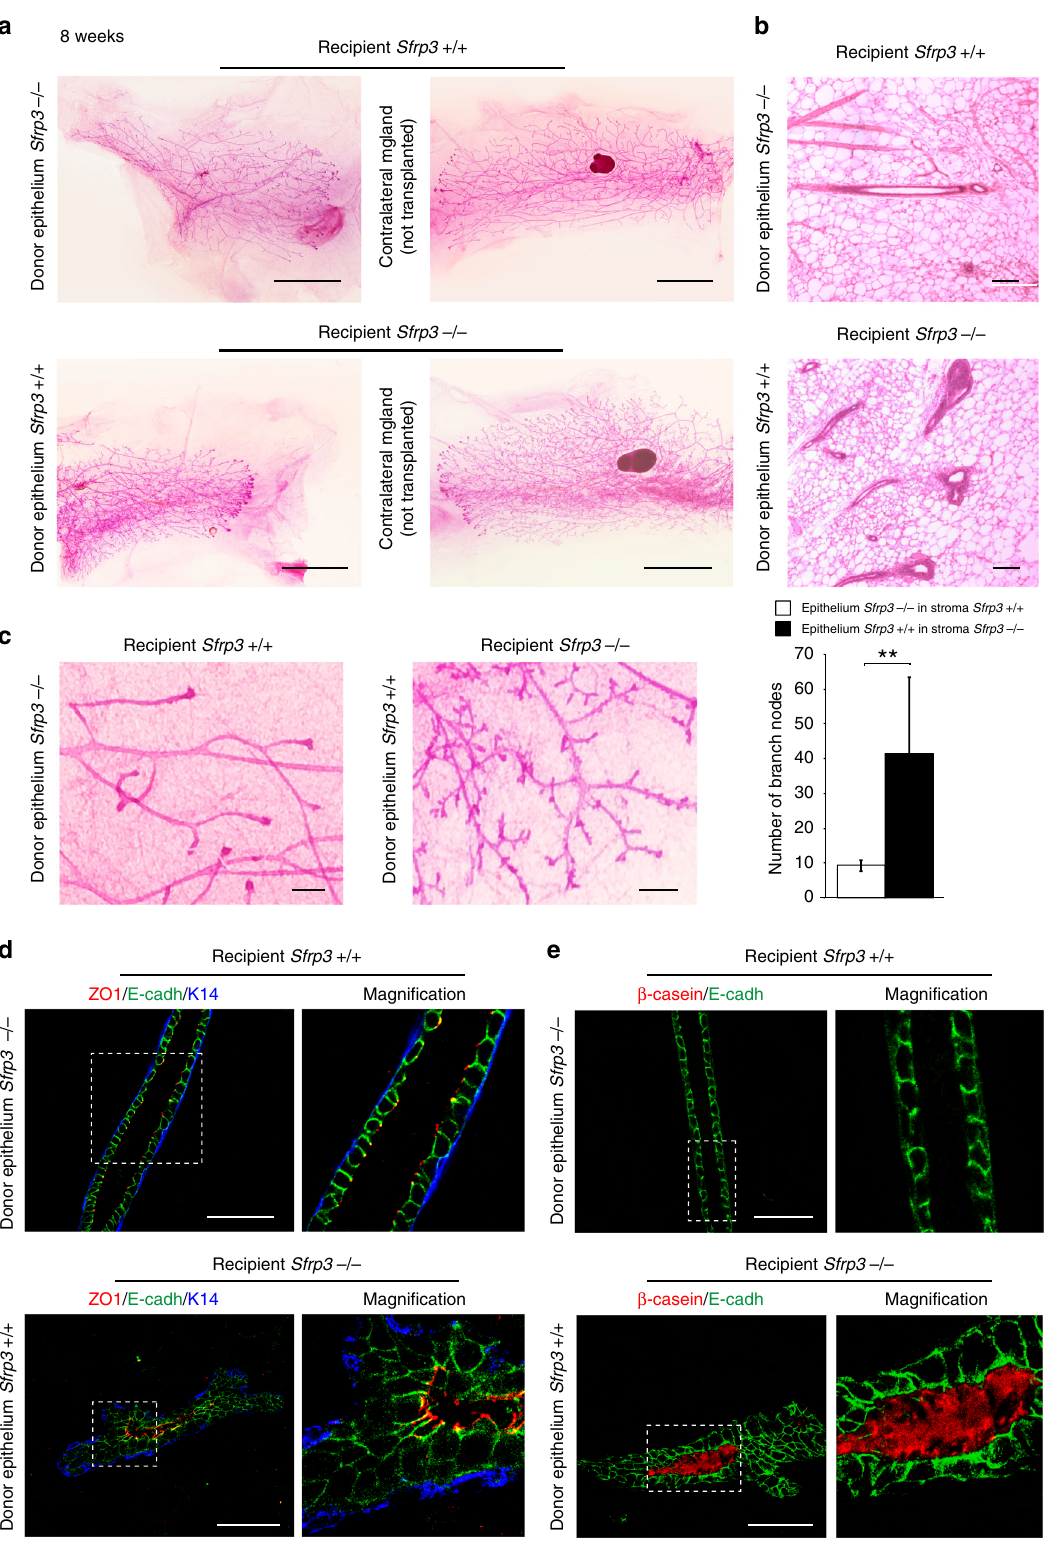
(Fig. 5g), demonstrating that Sfrp3 is not a repressor or inhibitor of Wg, but more likely a transporter of Wg that allow the spreading of this morphogen. Next, we investigated whether canonical Wnt signalling is abnormally activated in Sfrp3 − / − MGs. Next-generation sequen- cing (NGS) analysis of sorted adult MG epithelial cells showed